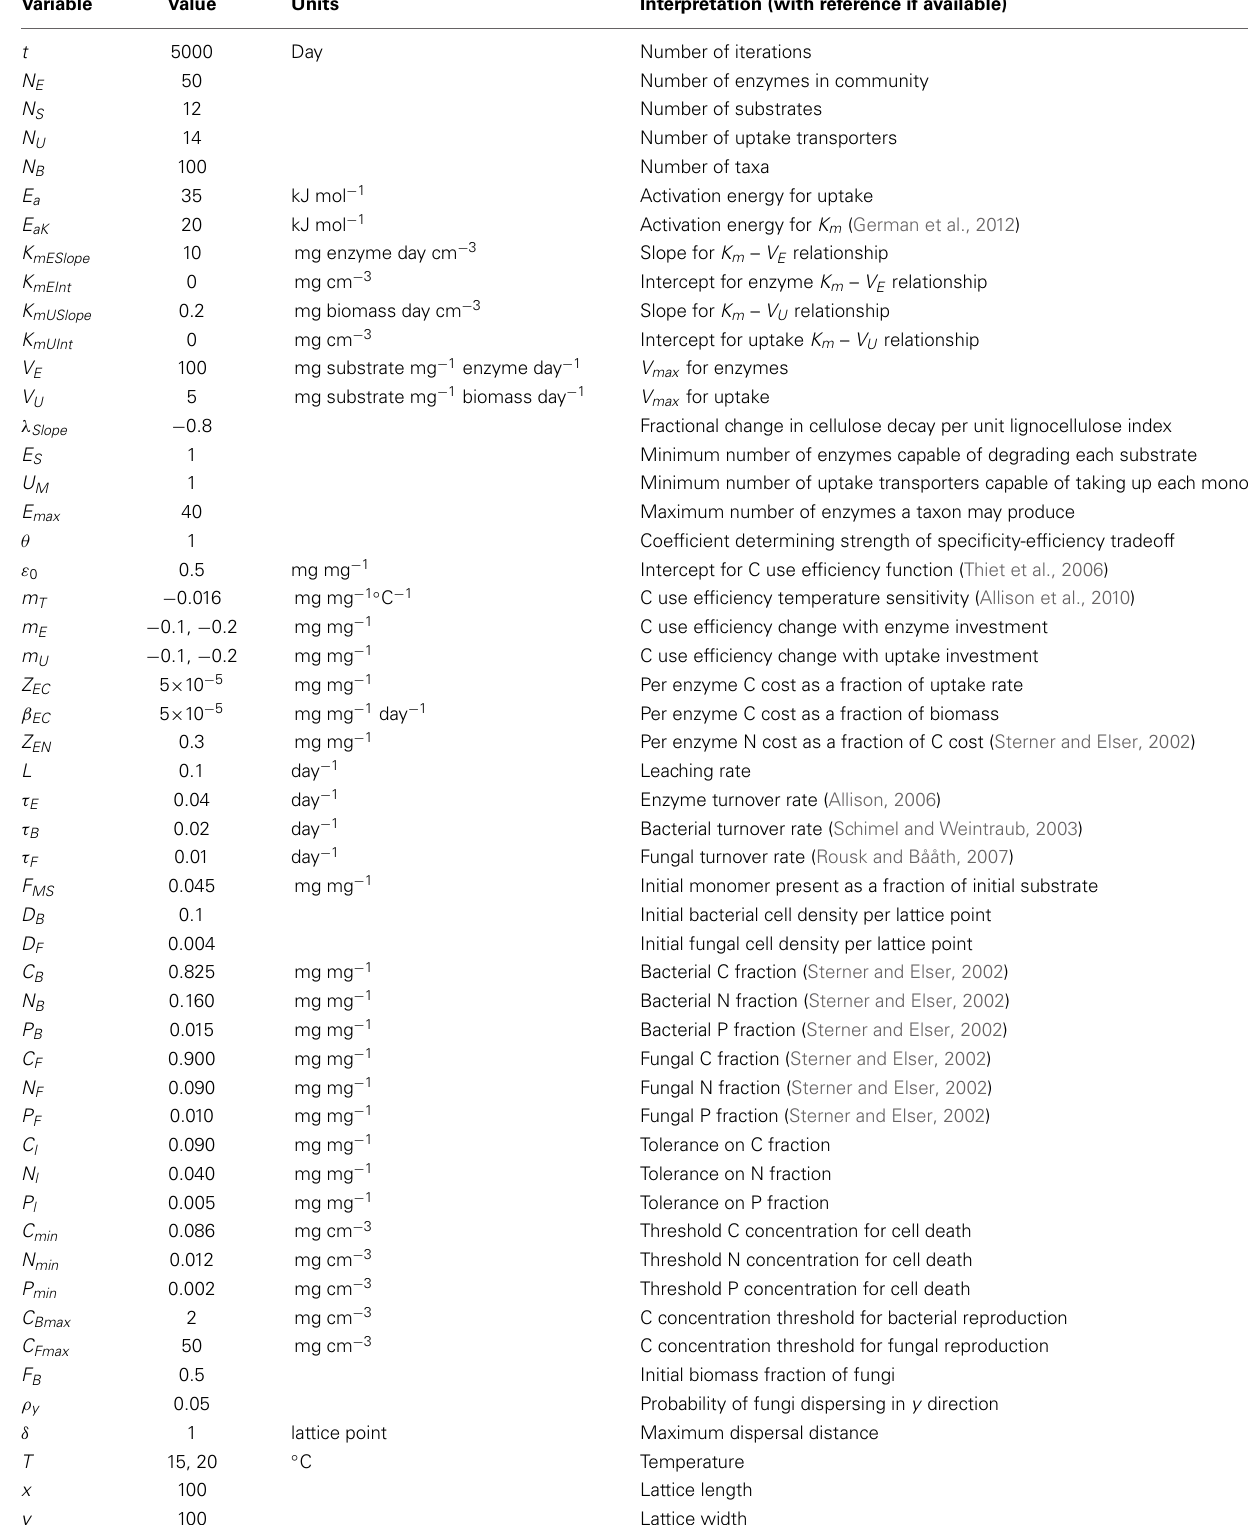
Table 1 | Values and units for model parameters.